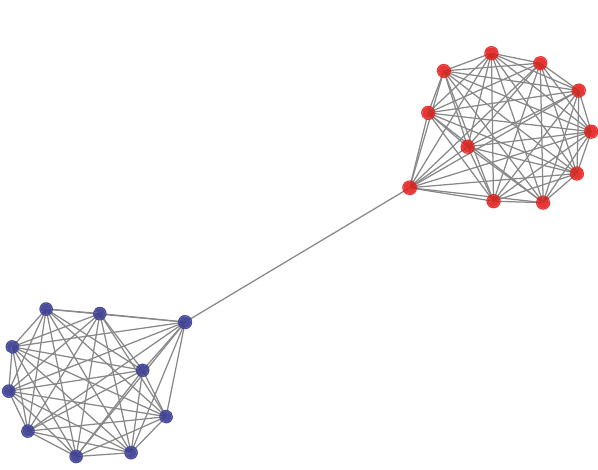
Figure 4: Copeland-Erd¨os network.